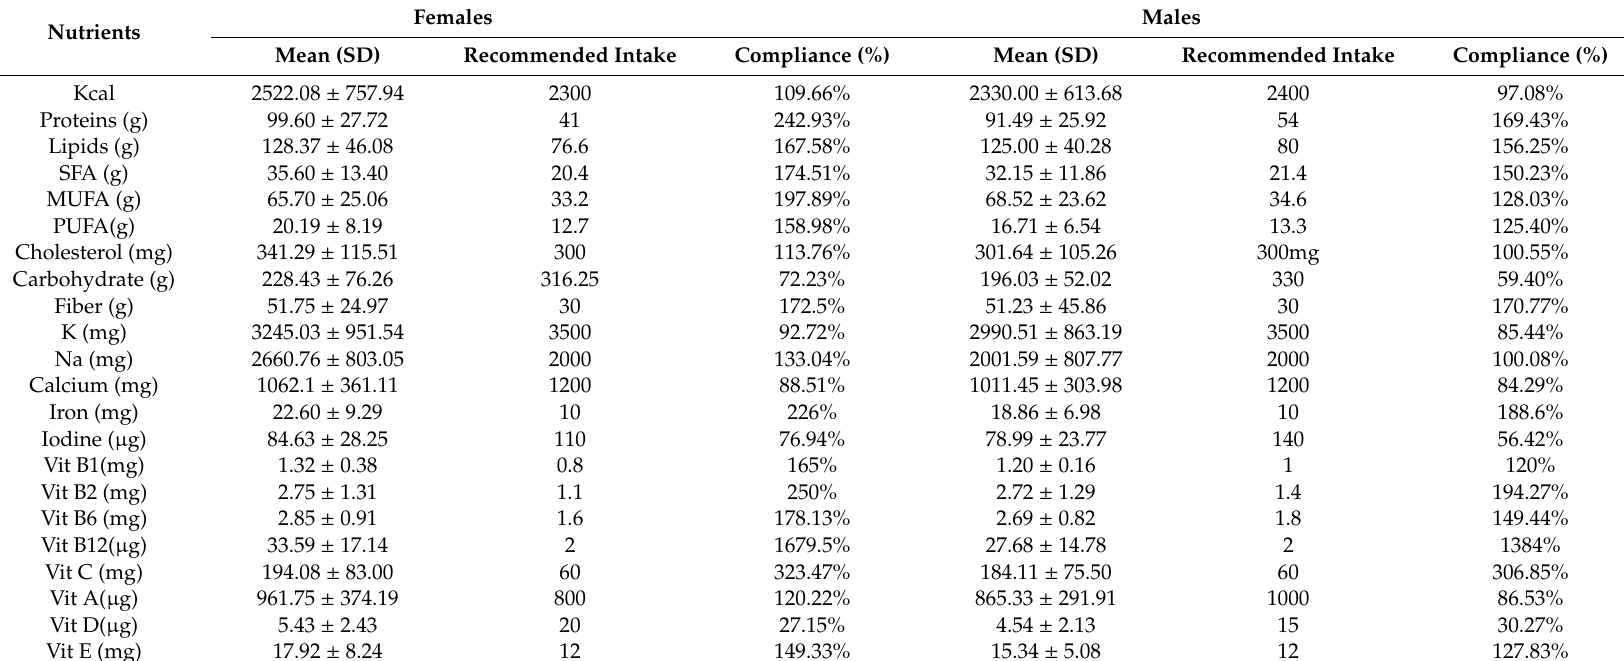
Table 2. Average nutrient intake based on